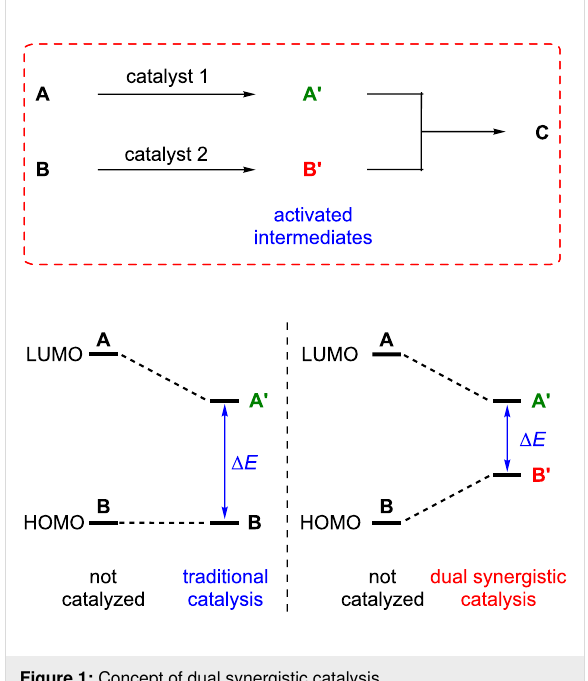
Figure 1: Concept of dual synergistic